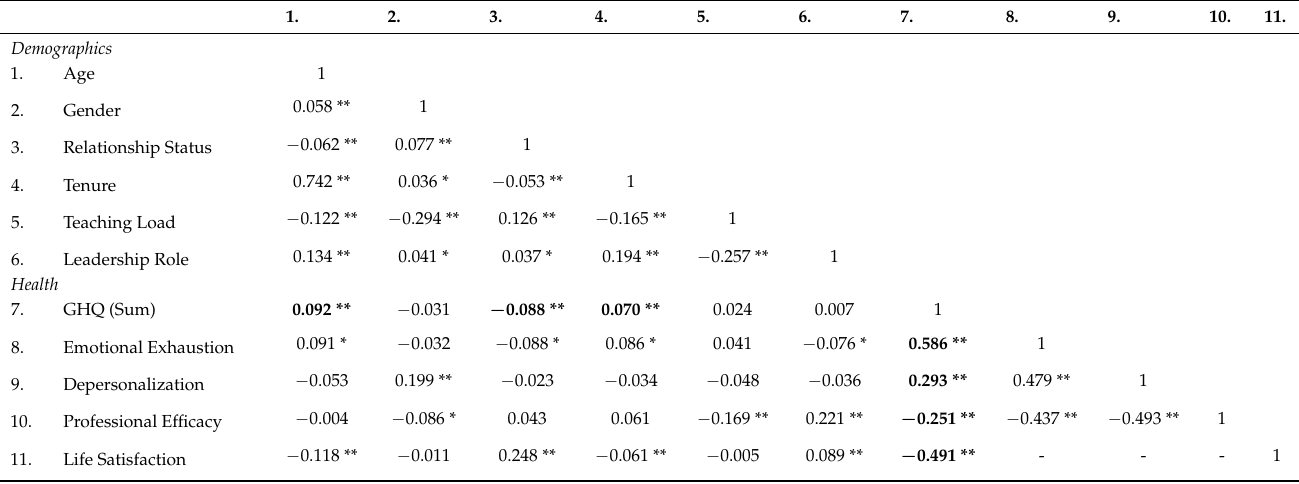
Table 2. The correlations between the demographics and the health